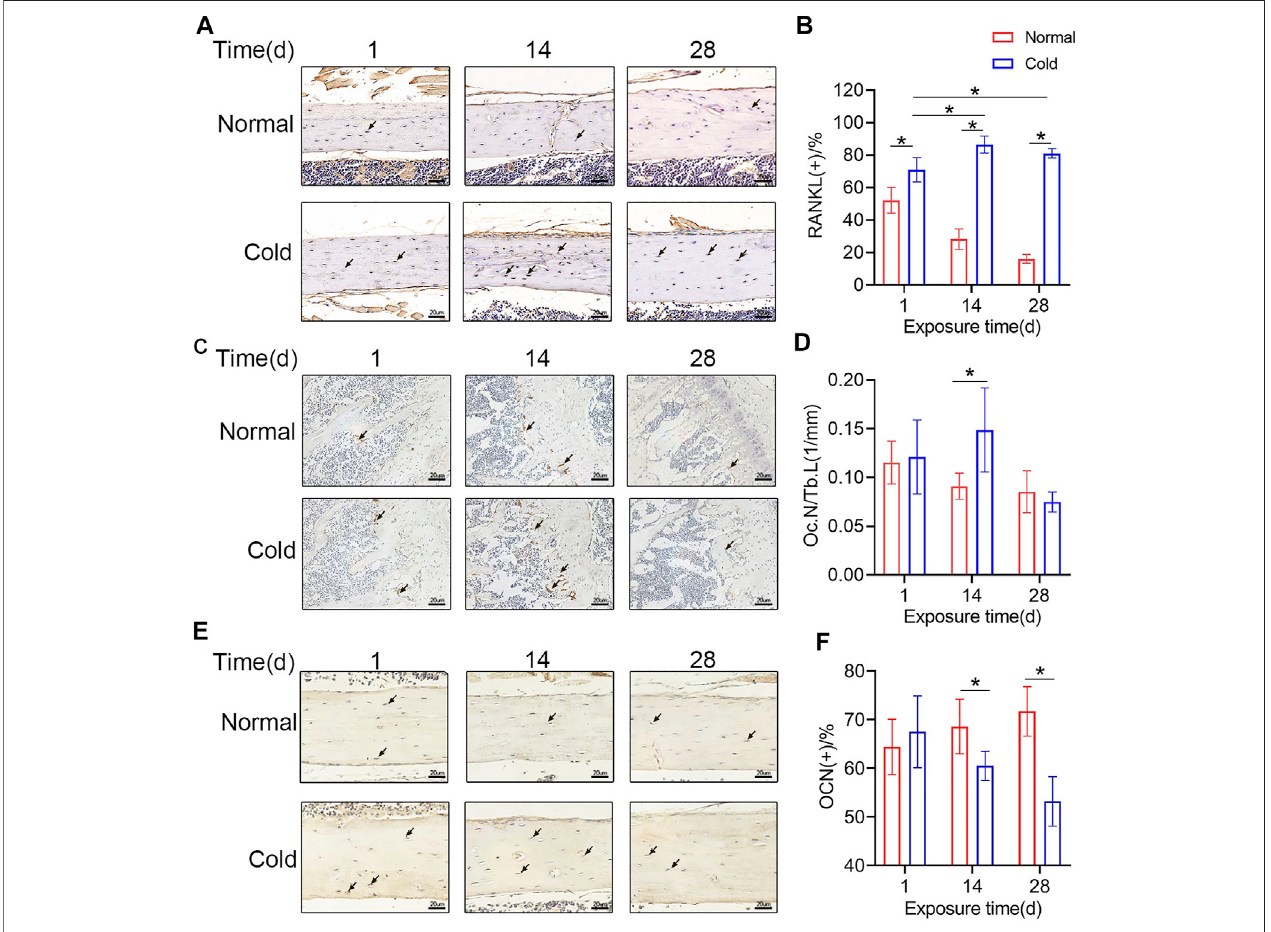
FIGURE 4 | Cold affects the secretory function of osteocytes (A) Immunohistochemical staining for RANKL in the femurs was performed. (B) RANKL-positive osteocytes were calculated and are statistically represented. (C – D) Immunohistochemical staining for TRAP in the femurs was performed and Oc. N/Tb.L were calculated. (E – F) Immunohistochemical stainingforOCNinthefemurs wasperformedand OCN positiveosteocyteswerecalculated.Blackarrows: RANKL-, TRAP-,or OCN-positive osteocytes. Data are shown as the mean ± SD ( n (cid:2) 5). Signi fi cance ( p value) was calculated using two-way ANOVA, * p < 0.05.